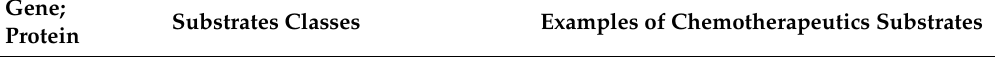
Table 1. Classes of substrates and examples of chemotherapeutics transported by drug-related ABC